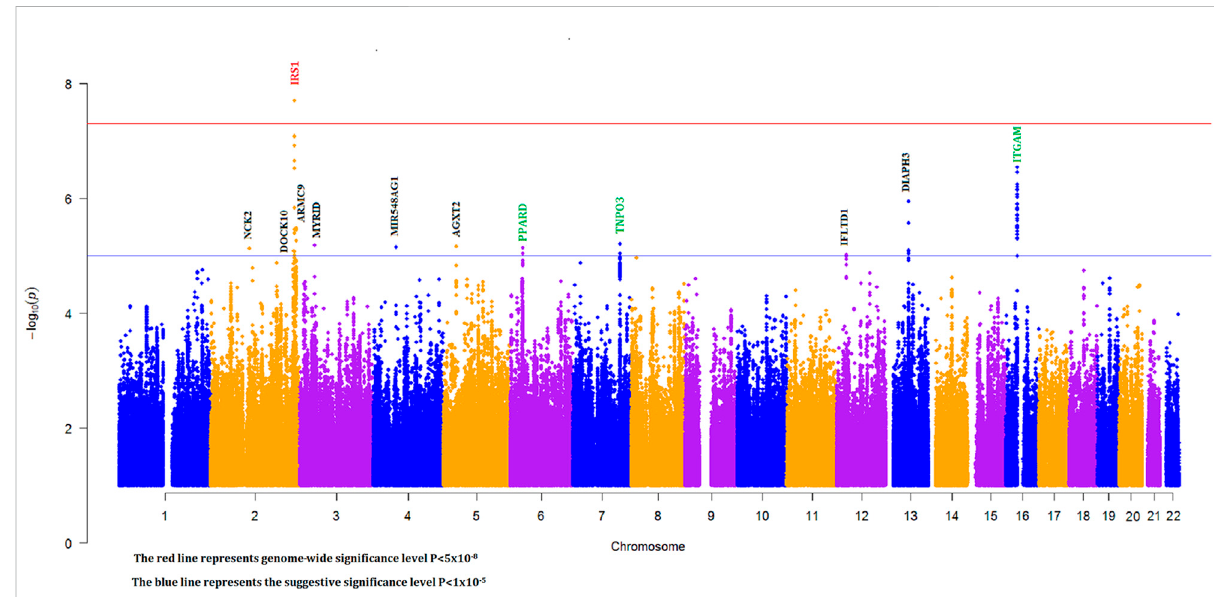
FIGURE 2 Manhattanplotforimputation-basedassociationwithindividualancestrycorrection(green,black,andredgenenamesrepresentknown,novel suggestive, and novel genome-wide signi fi cant loci,